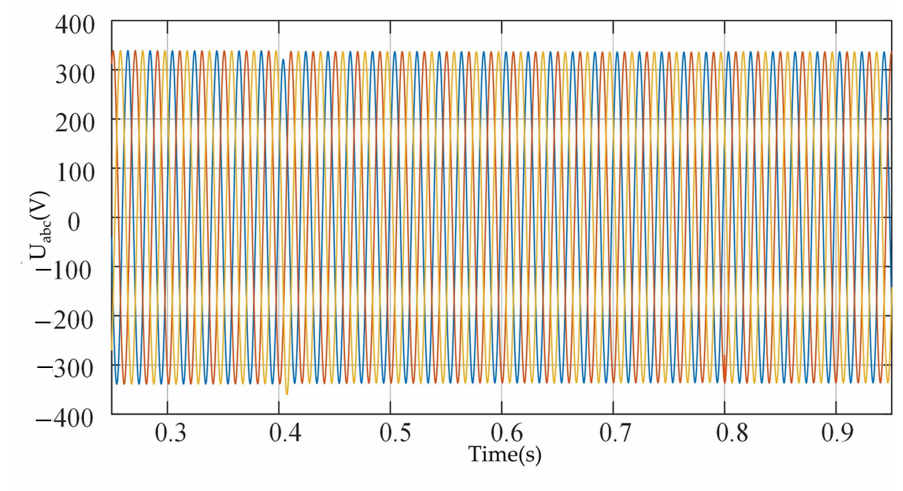
Figure 12. Three-phase voltage variation situation result of case-2.